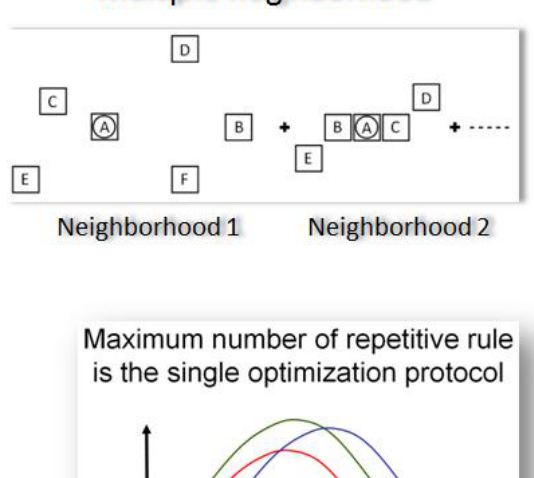
Figure 22. ( a ) Fractal seeds are searched in a grid following four rules, simultaneous evolution of multiple states (top-left), multiple neighborhoods (top-right), multiple states of a single switch (bottom left) and optimizing number of repititive rules (bottom right); ( b ) The size of grid is checked by seeing dynamics; ( c ) Multi-layered image decomposition.